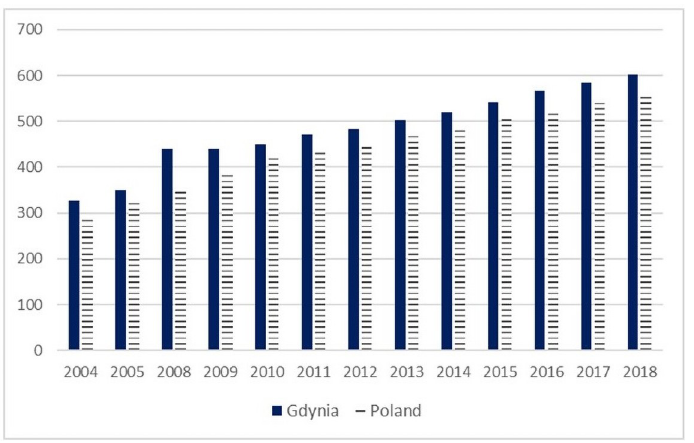
Fig 3. Motorisation rate index in Gdynia and Poland in 2004–2018 [passenger cars /1000 inhabitants]. Source : self- study on